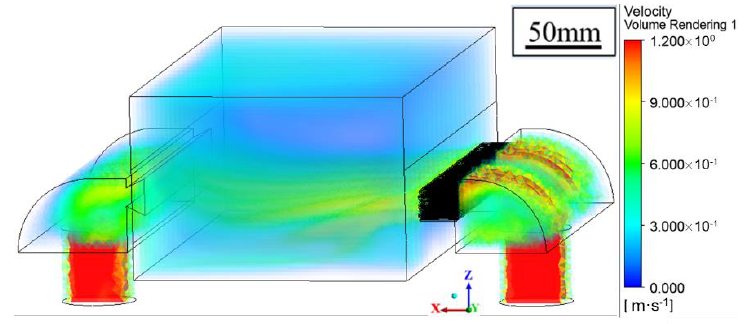
Figure 8. Velocity distribution of shielding gas flow obtained by simulation.